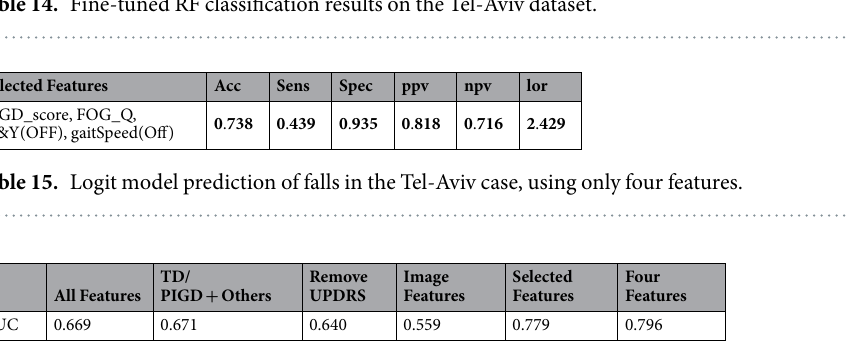
Table 16. Performance of the RF falls/no-fall classifier under different conditions.